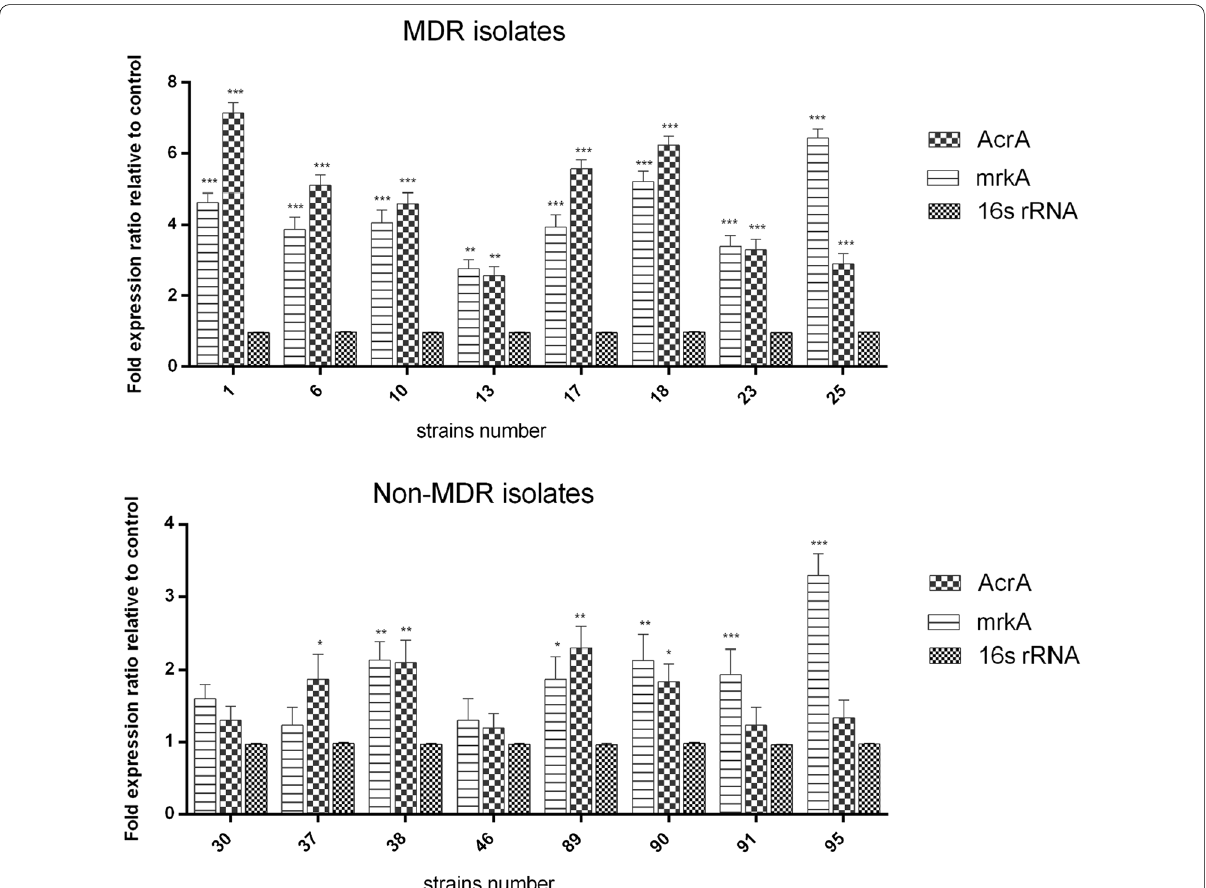
Fig. 2 acrA and mrkA relative gene expression among MDR and non-MDR strains as fold difference between AcrA, mrkA gene and 16 S rRNA gene as a housekeeping gene. *** p < 0.001, ** p < 0.01, * p <